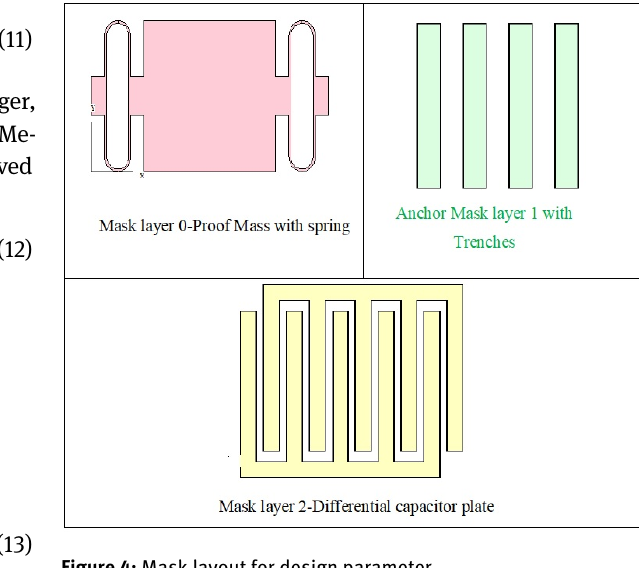
Figure 4: Mask layout for design